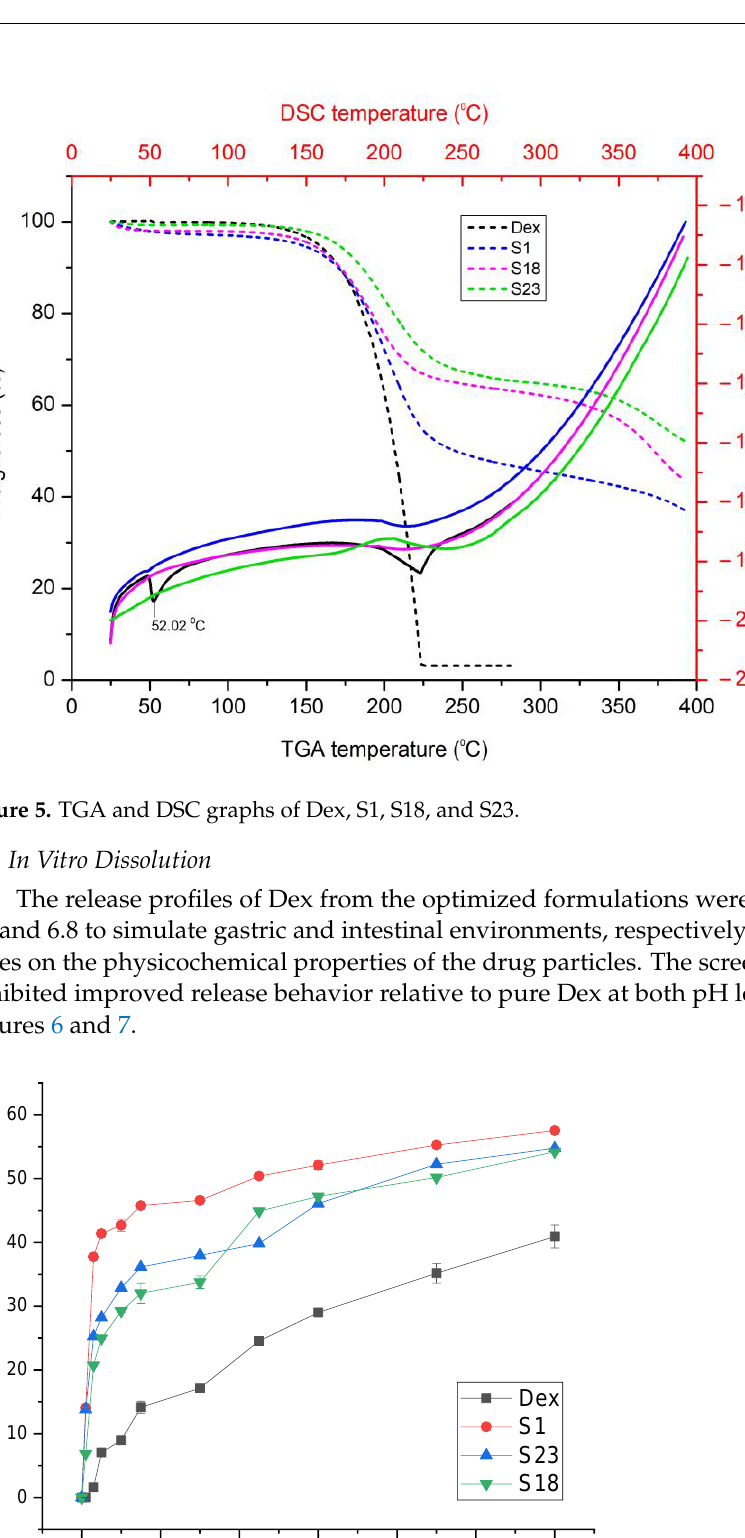
Figure 6. Dissolution profile of Dex and optimized formulations at pH 1.2. The error bar designates the standard deviation (n = 3).